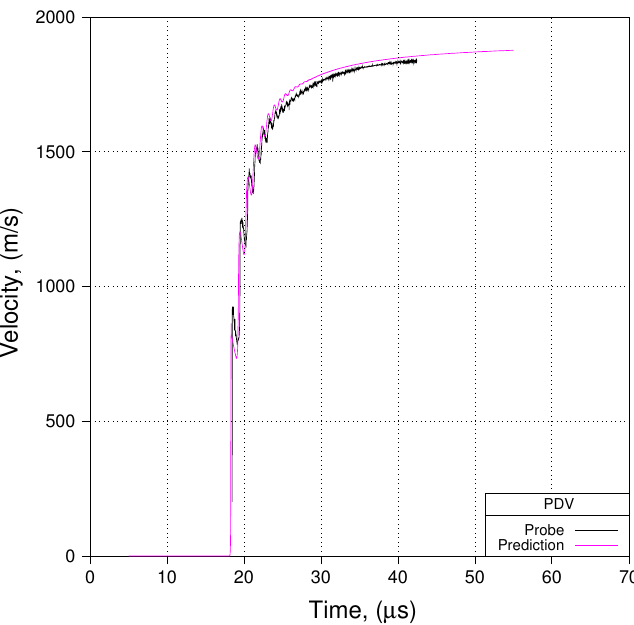
Figure 16. Prediction to Data: Shot 01, Probe 03,